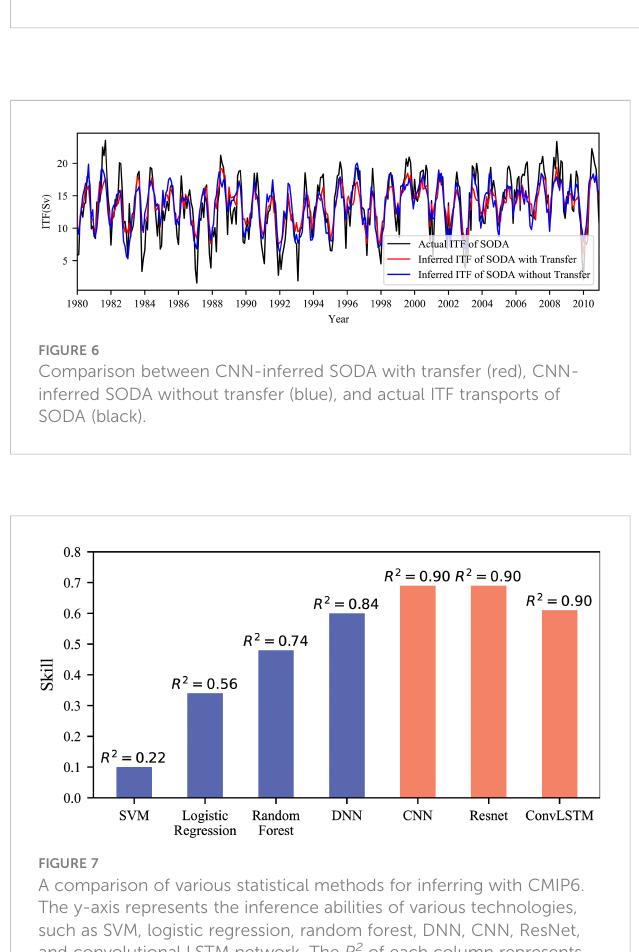
FIGURE 5 A comparison of CNN-inferred and actual ITF CMIP6 transports. (A) The x-axis represents the range of CMIP6 actual ITF, while the y-axis represents the inferred ITF for each actual ITF. The black dotted lines show where the inferred ITF equals the CMIP6-actual ITF. The scatter diagram shows that the CNN explains more than 90% of the traf fi c variance (max achieves R 2 = 0.90). (B) The histogram demonstrates the bias of underestimated transportation extremes. The actual ITF transport is shown in black, while the inferred ITF transport is shown in red. (C) Time series of actual transport (black) and inferred ITF transport (red) when the skill is 0.69.